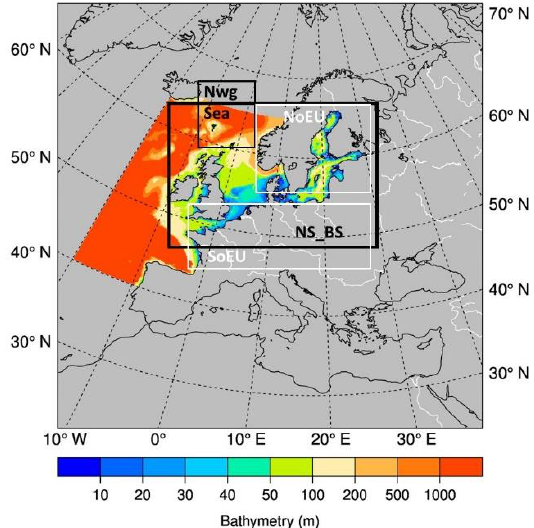
Figure 2. Model domains (CCLM and HD: Grey, NEMO: Color). Four rectangles show four sub-domains used in analysis NwgSea (Norwegian Sea), NS_BS (the North and Baltic Sea), NoEU (north Europe), SoEU (south Europe).